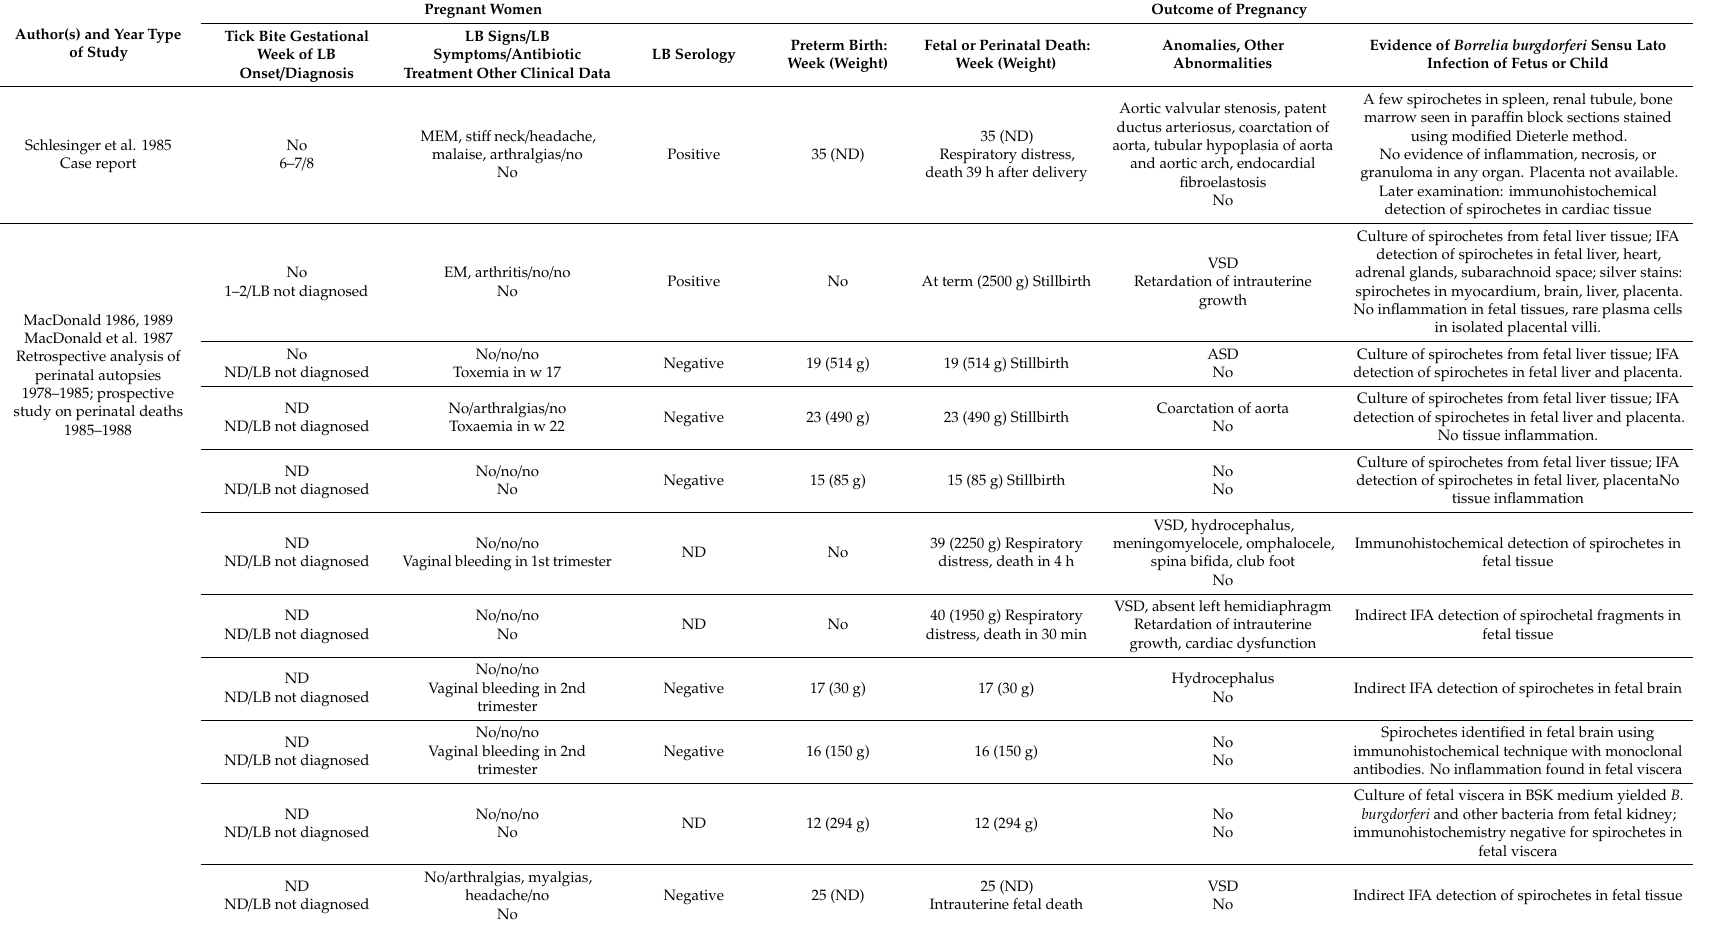
Table 4. Reports on unfavorable outcomes of pregnancy in patients with Lyme borreliosis during